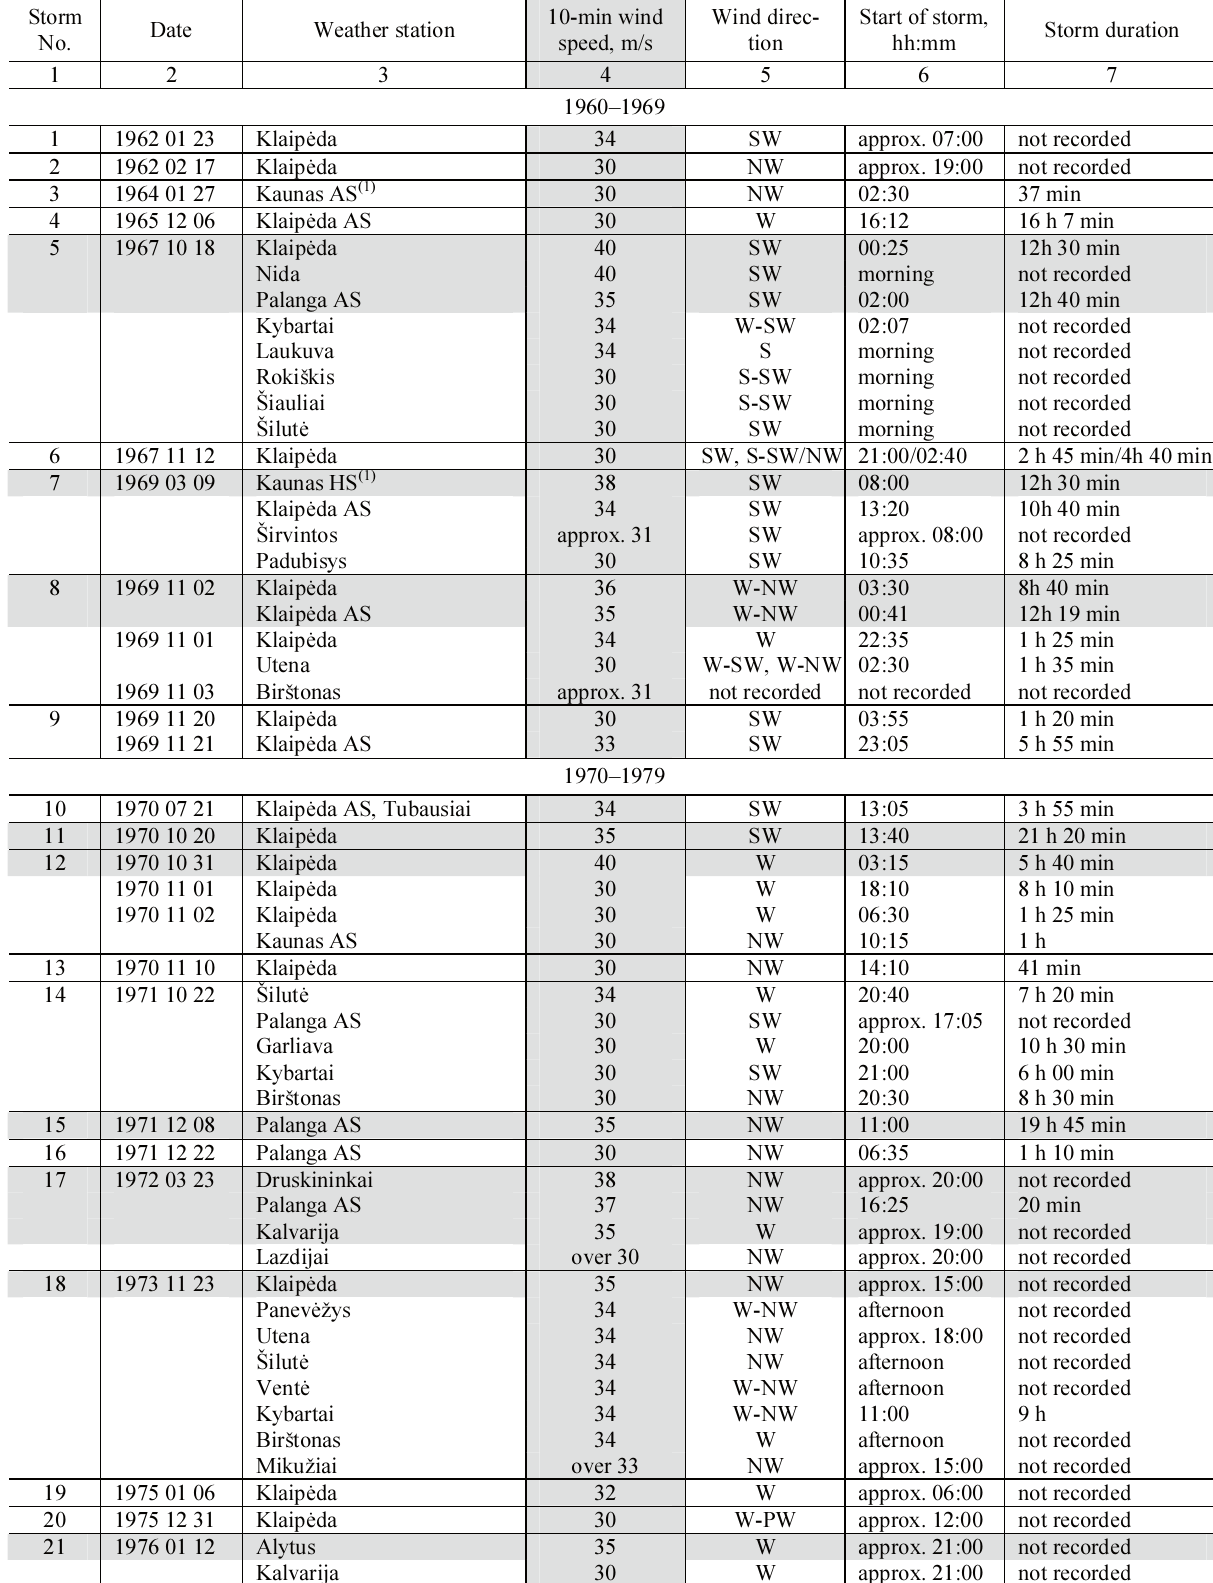
Table 1. General data on storms with 10-min. wind speeds of at least 30 m/s recorded in Lithuania in the 44 year period of 1962– 2005 (extracted from Korkutis (2000) and Lietuvos hidrometeorologijos tarnyba (2008)) Storm